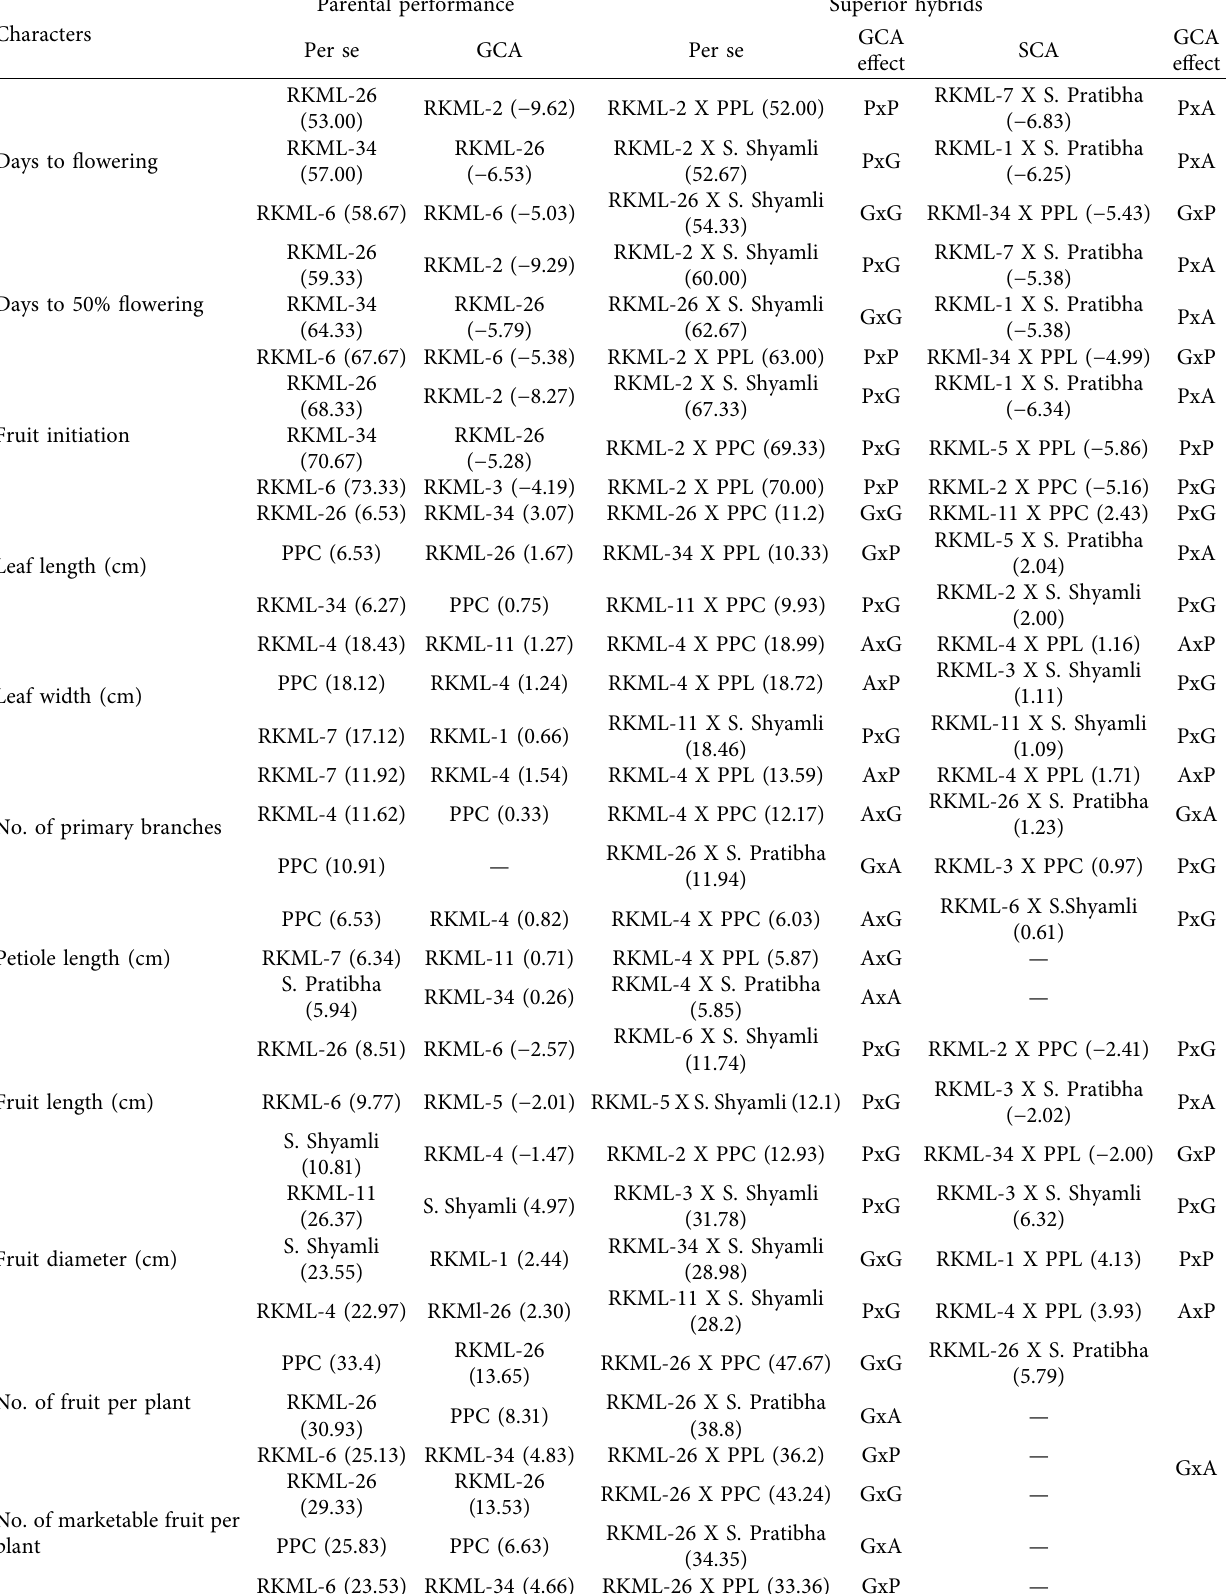
Table 4: Top three best performing parents (per se and GCA) and hybrids (per se and SCA) for various characters in brinjal.